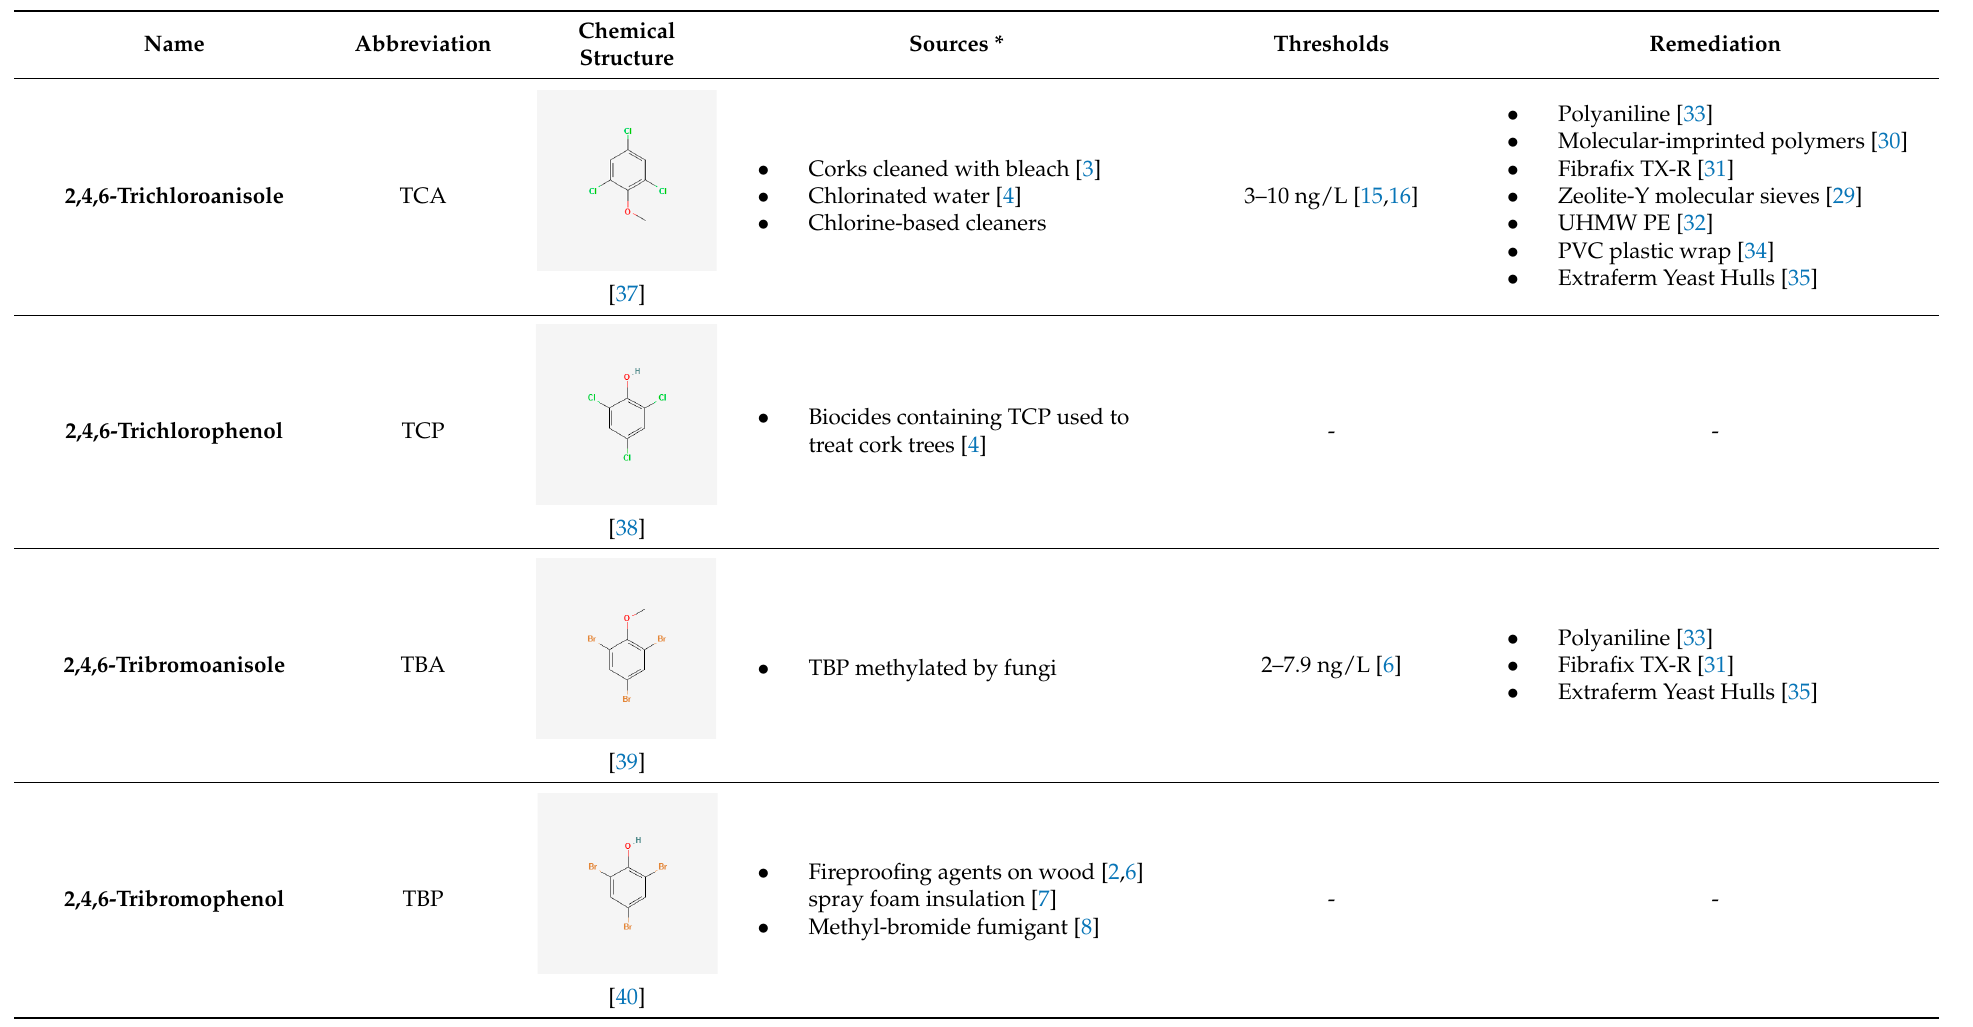
Table 1. Haloanisoles and halophenols.